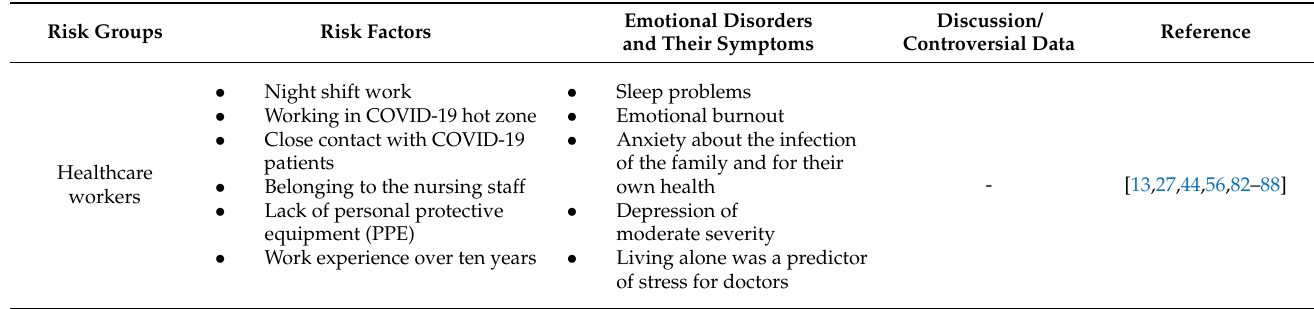
Table 2. Established specific risk groups for emotional disorders during the COVID-19